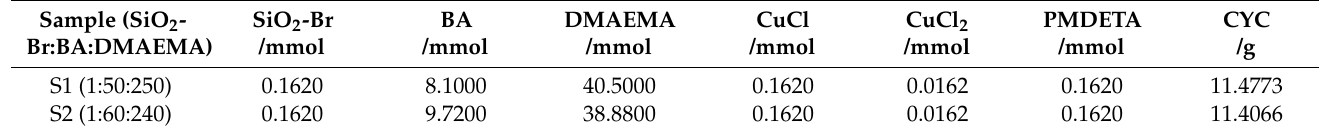
Table 1. Detailed recipes for prepared samples.